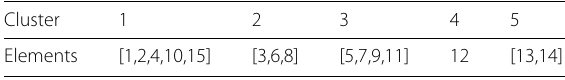
Table 3 Output of the clustering algorithm